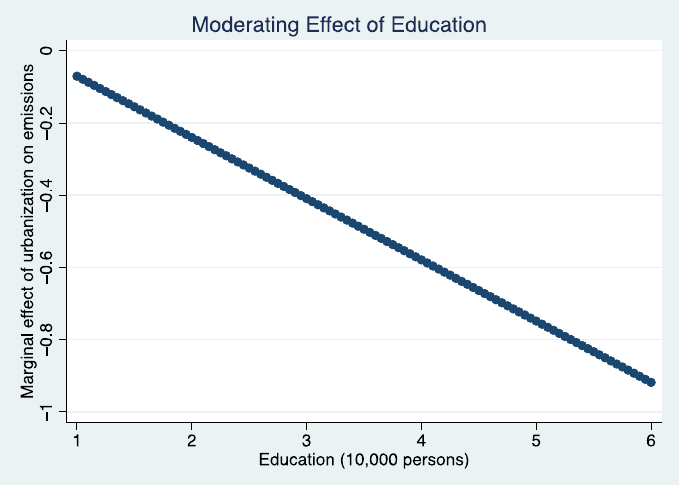
Figure 7. Moderating effect of education.